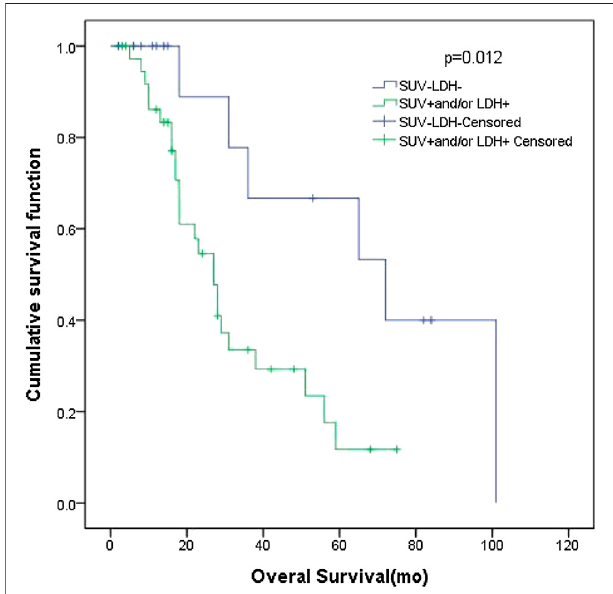
FIGURE 4 | Survival curves of SUV max of different primary tumor and LDH in 54 LD SCLC